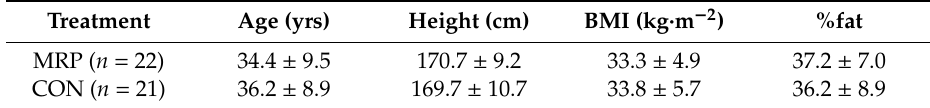
Table 1. Demographic descriptive data for modified intention to treat analysis. Mean ± Standard